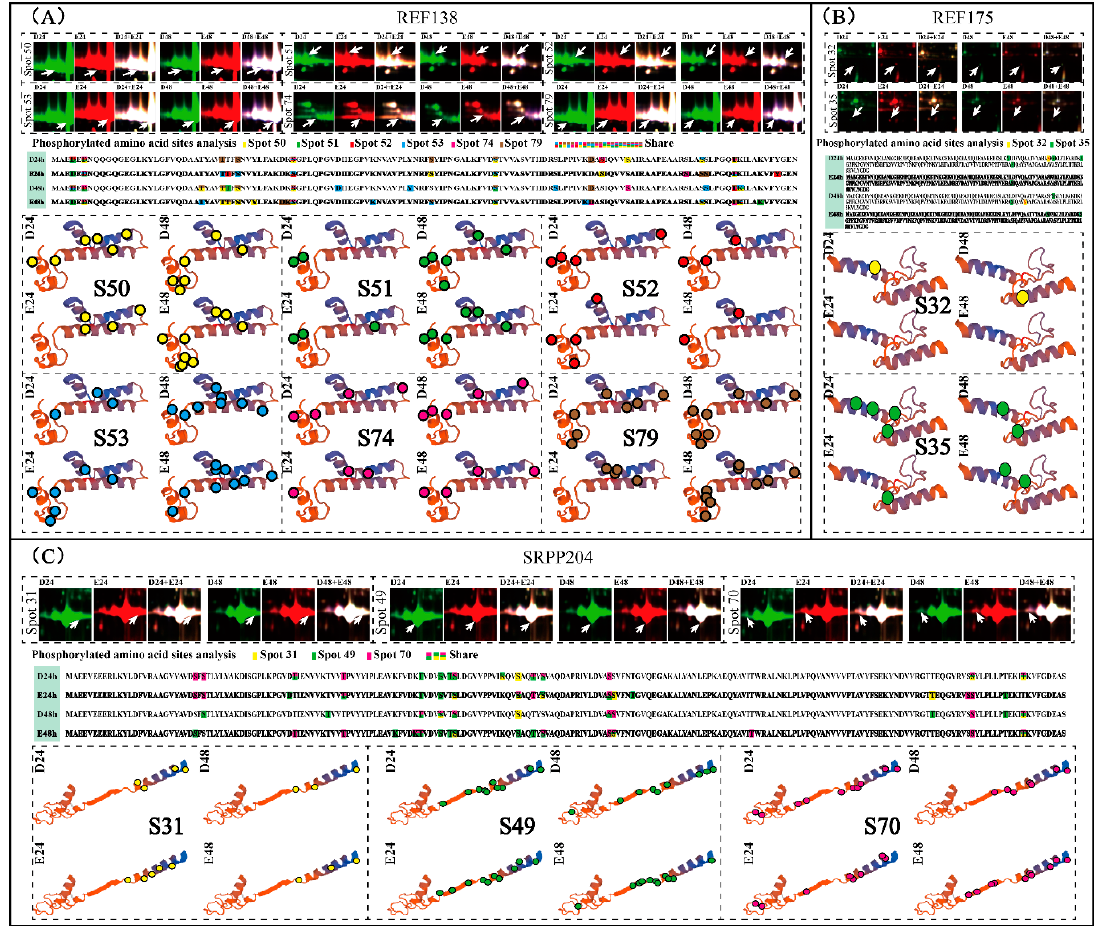
Figure 3. Phosphopeptides and phosphorylated amino acids in different REF and SRPP members. The changed pattern of different protein spots after the D24, D48, E24, and E48 treatments on the DIGE gels, phosphorylated peptides, phosphorylated amino acid sites, and the predicted 3-D structures for REF/SRPP family members REF138 ( A ), REF175 ( B ), SRPP204 ( C ), and REF258 (Figure S2) are highlighted. The capital letters and circles with different color represent the phosphorylated amino acids in different protein spots. The detail information for these peptides and phosphorylated amino acid sites is listed in Figure S3 and Table S2.